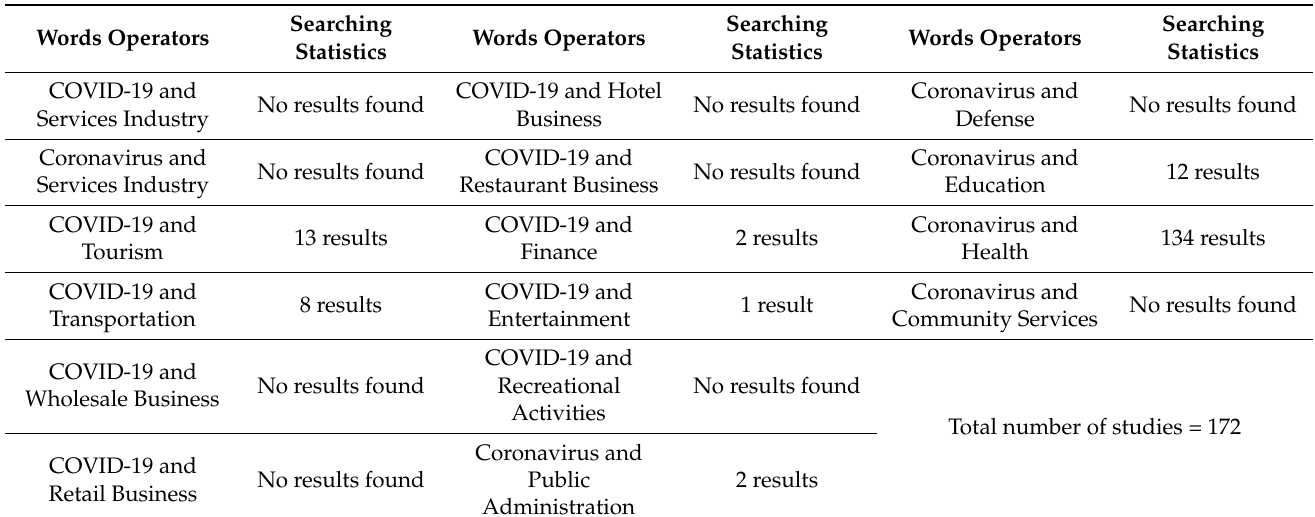
Table 1. Assessment of Scholarly Writings on COVID-19 and Services